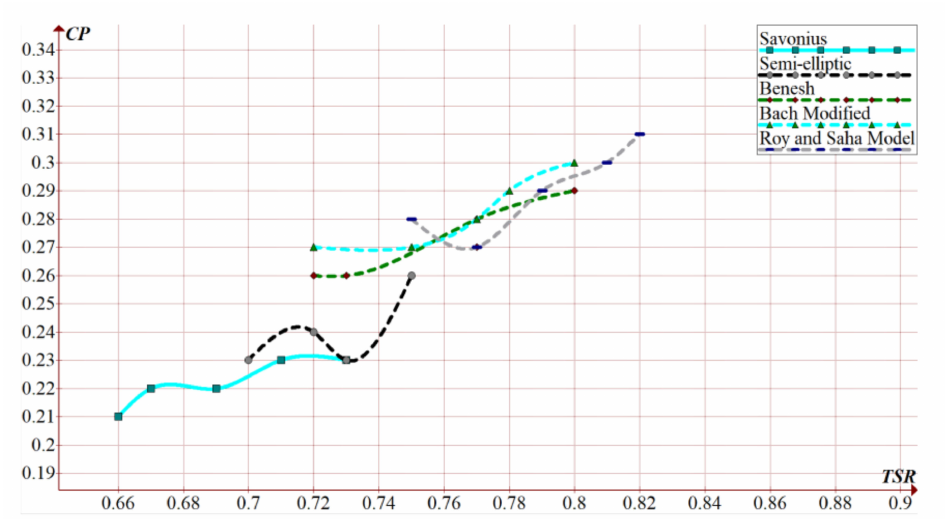
Figure 12. Power coefficient values obtained for the analyzed rotor profile models [68–71].